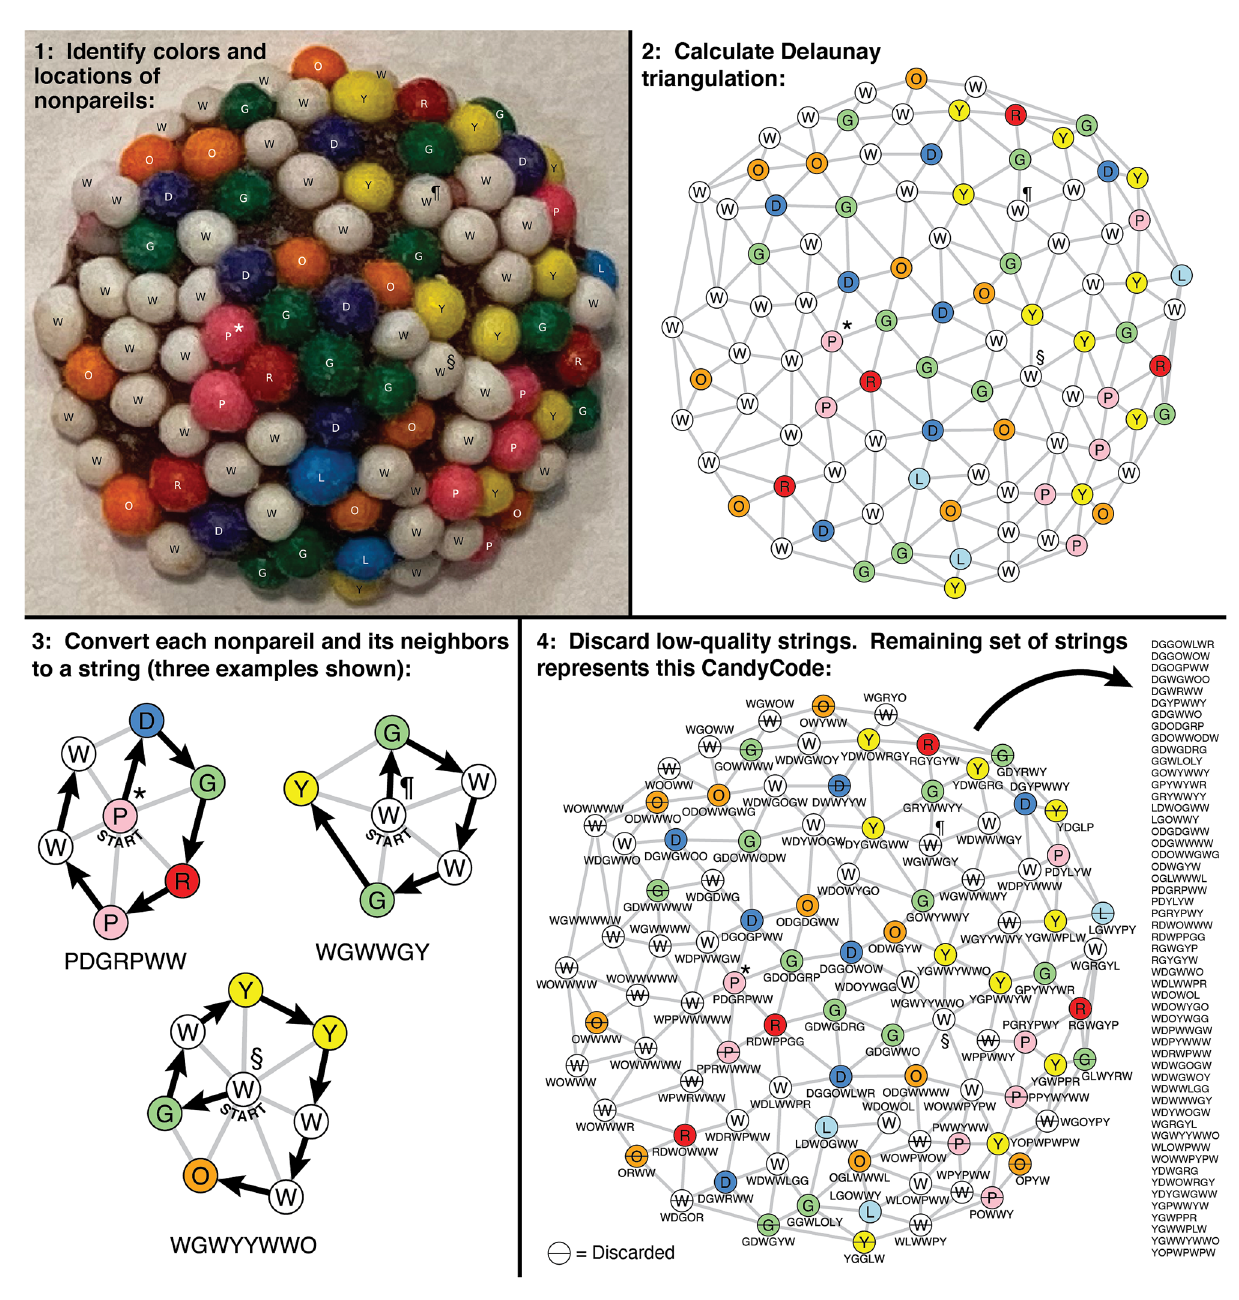
Figure 4. Converting a photograph of a CandyCode (number 44 from Fig. 3) into a set of strings suitable for storage and querying in a database. In Step 1, the locations and colors of all visible nonpareils are recorded. In Step 2, the nonpareil locations and colors are interpreted as vertices on a graph, and the Delaunay triangulation 24–26 of these vertices connects neighboring nonpareils via the edges on the graph. Next, for each nonpareil and its immediate neighbors, the colors of each nonpareil and their arrangement around the central nonpareil are used to create a text string. Step 3 shows three example string conversions, for the nonpareil neighborhoods marked with “ ⋆ ,” “ ’’ and “ ” in each step (details in main text). In Step 4, any low-quality strings ( e.g., those containing too-few different colors or located on the edge of the graph) are discarded. The remaining set of 53 strings represents this CandyCode, and this set is saved to the database of known-good CandyCodes. This process is repeated for every CandyCoded pill before leaving the manufacturer. When a consumer photographs a CandyCoded product and submits the photo for analysis, this process is repeated using the consumer’s photo, and the resulting set of strings is compared with the database of known-good string sets. If a known-good CandyCode is found that contains many of the same strings as the user’s CandyCode, then the user likely has an authentic